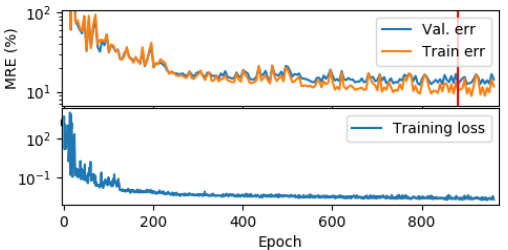
Figure A1. Training errors, validation errors and training losses shown on a logarithmic scale. Although the training loss contin- ues to slowly drop after the epoch with the lowest validation error (red line, at epoch 881), validation error stays relatively flat, sug- gesting that the ConvNet is overfitting after this epoch. The gradual decrease in MRE is less smooth than the training loss because the loss function is mean squared error, whereas the MRE is propor- tional to the mean absolute